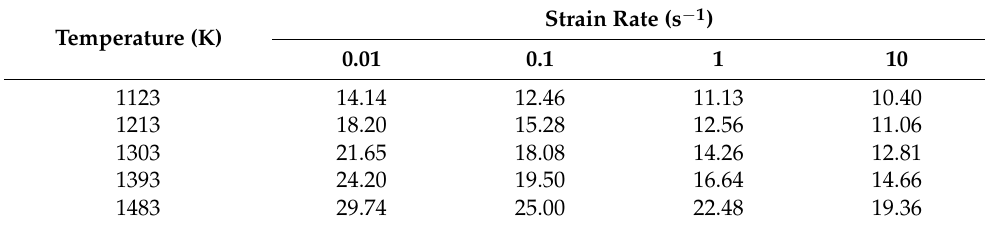
Table 6. Values of h under temperatures of 1123–1483 K and strain rates of 0.01–10 s − 1 .